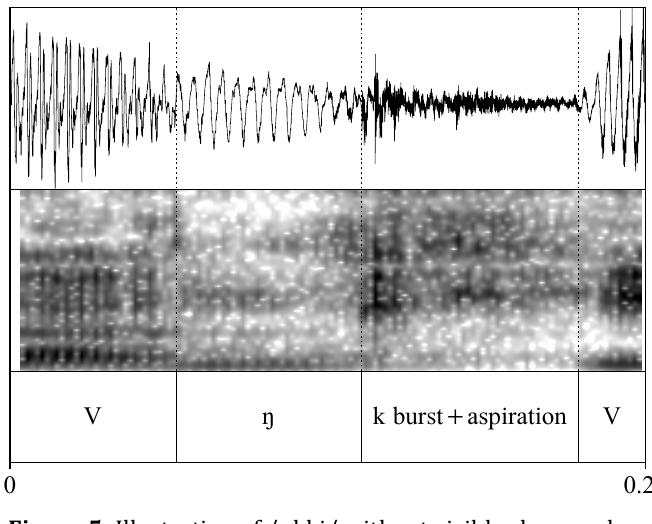
Figure 5: Illustration of /ŋkhi/ without visible closure